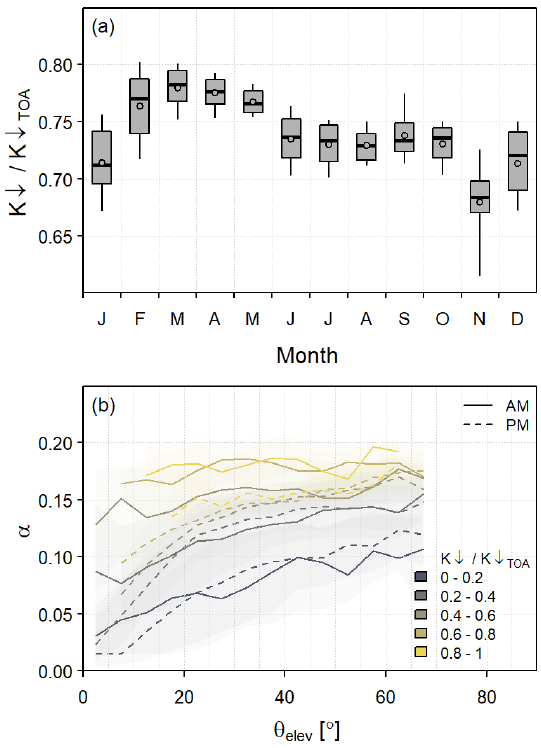
Figure 10. (a) Monthly box plots of the midday (11:00–15:00CET) clearness index K ↓ /K ↓ TOA at IAO for clear-sky days. Boxes indi- cate the interquartile range, whiskers the 10–90th percentiles and the median and mean are shown by horizontal bars and points, re- spectively. (b) Albedo ( K ↓ > 5Wm − 2 ; times with snow cover have been removed) at IAO versus elevation angle separated by clearness index and into morning (AM) and afternoon (PM) periods. Lines in- dicate binned median values and shading the interquartile